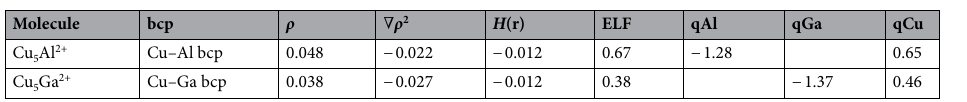
Table 1. Electron density ( ρ ) at the bond critical points, Laplacian of electron density ( ∇ ρ 2 ), total electronic energy density ( H (r)) and natural charges (q) in |e|. All other values are in a.u.